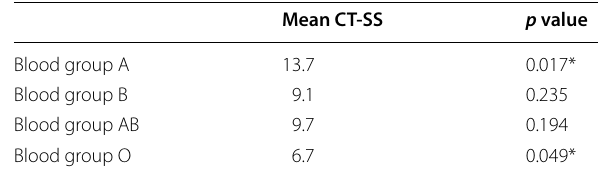
Table 1 Patients’ age and sex in relation to their blood groups Table 3 Correlation between the mean CT-SS and the ABO blood groups